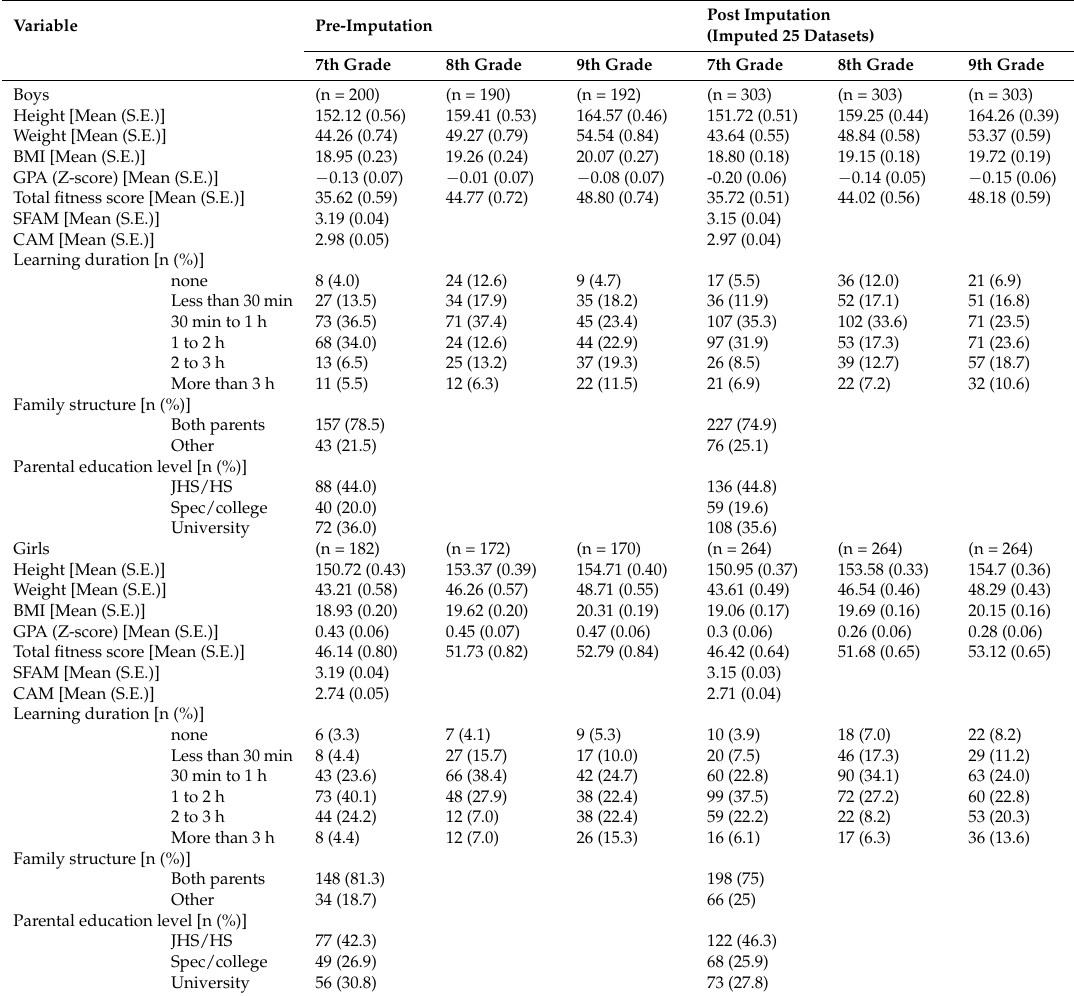
Table 1. Participants’ characteristics at each of the study periods.